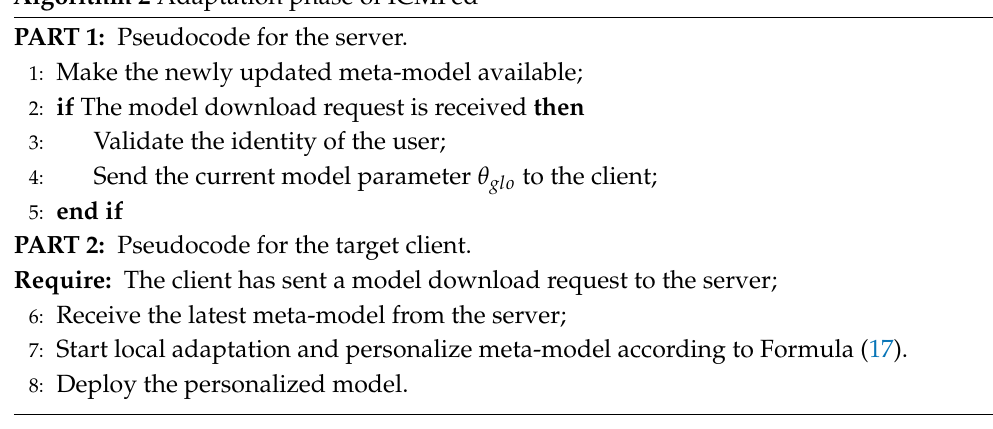
Algorithm 2 Adaptation phase of